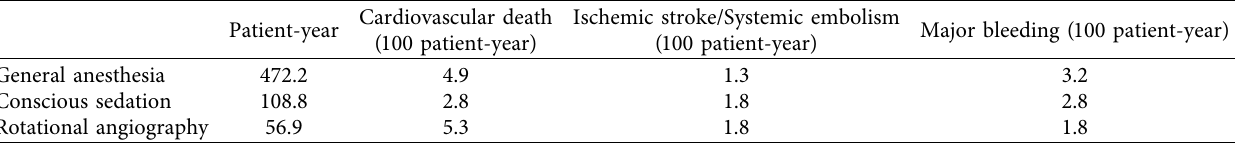
Table 3: Follow-up events. Comparison among approaches for cardiovascular death, ischemic stroke/systemic embolism, and major bleeding.